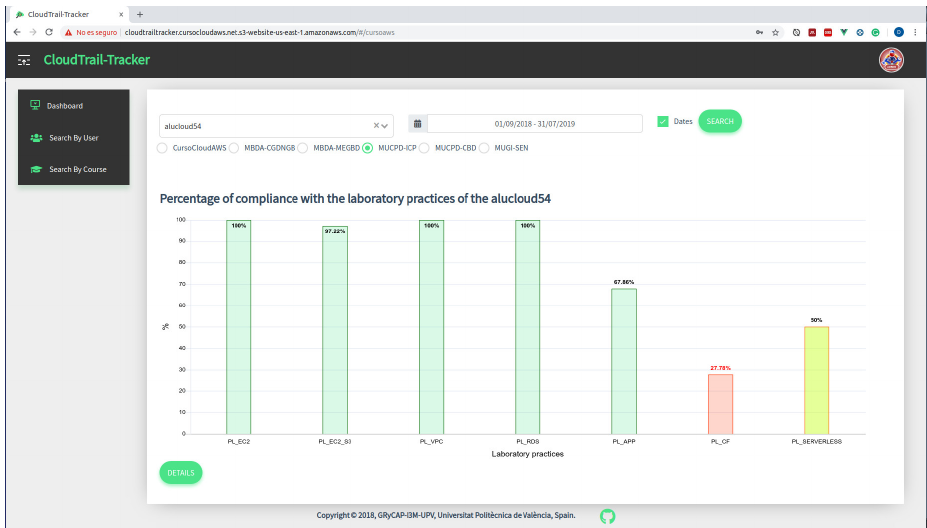
Figure 4. Percentage of completion for each hands-on lab for a specific